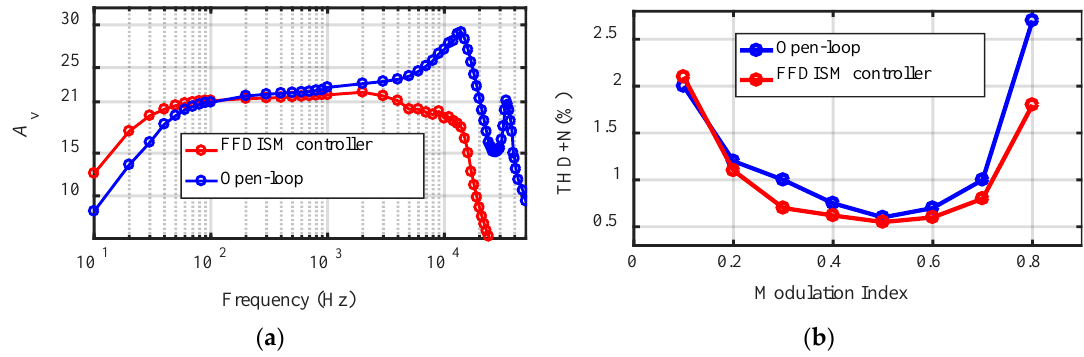
Figure 10. ( a ) Frequency response of the open-loop GaN class-D amplifier and with FFDISMC ( b ) THD+N the of open-loop GaN class-D amplifier and with FFDISMC.